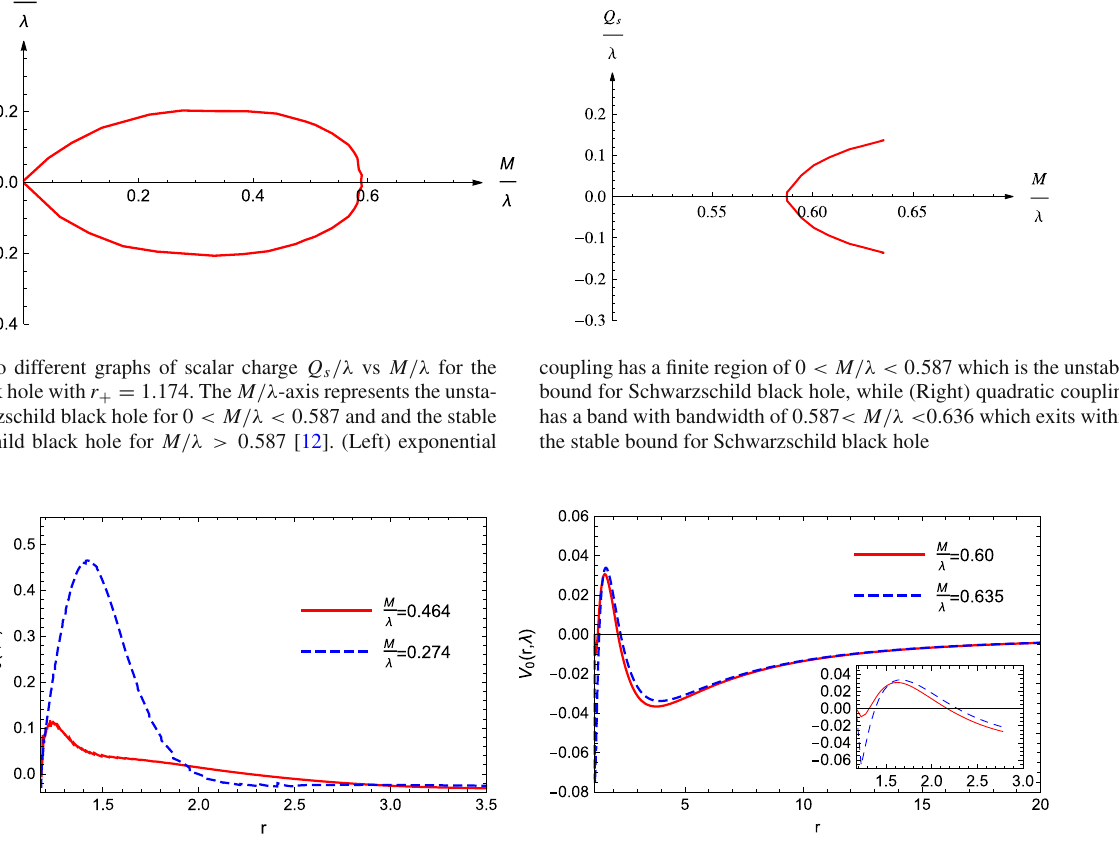
region shows the specific potential behaviors just outside the horizon, indicating negative-positive-negative